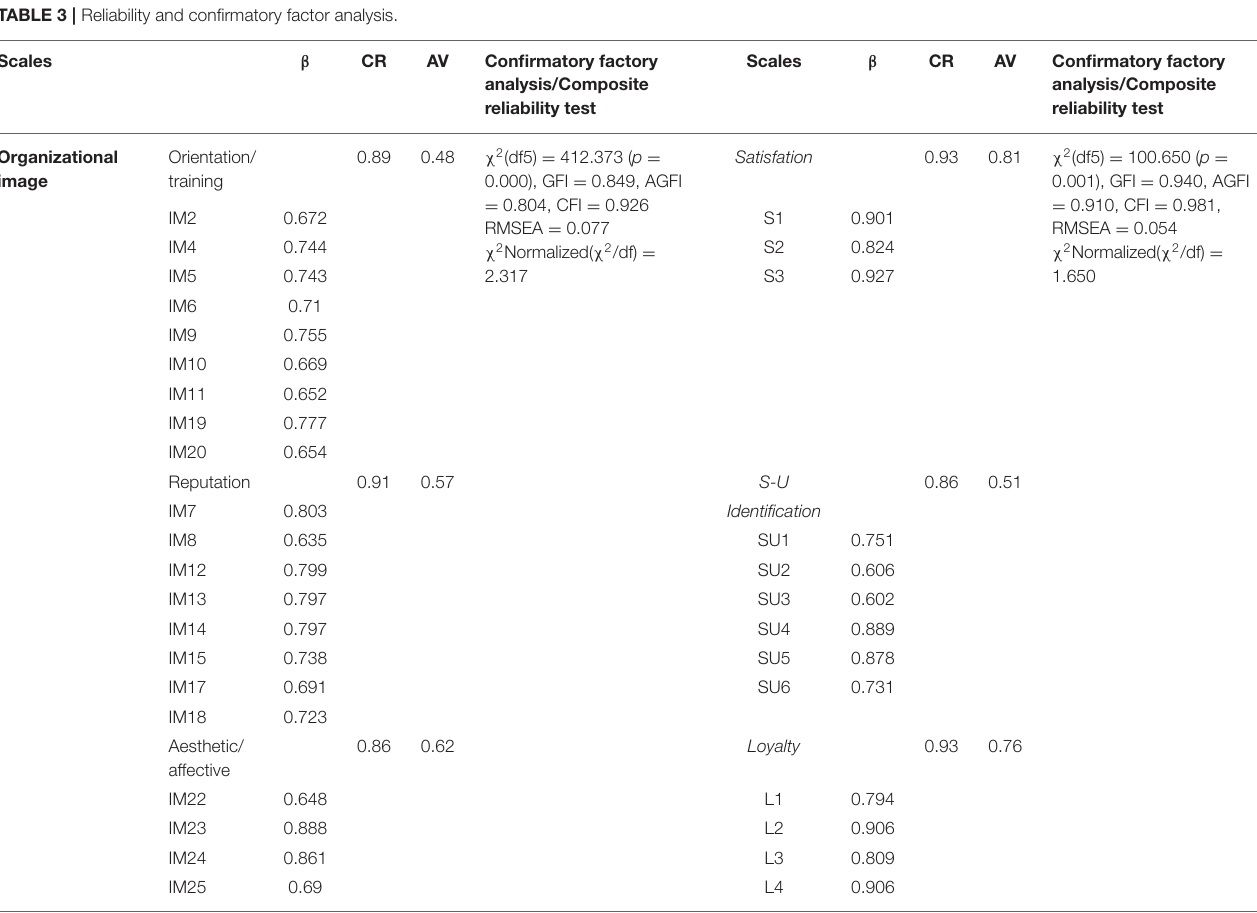
TABLE 3 | Reliability and confirmatory factor